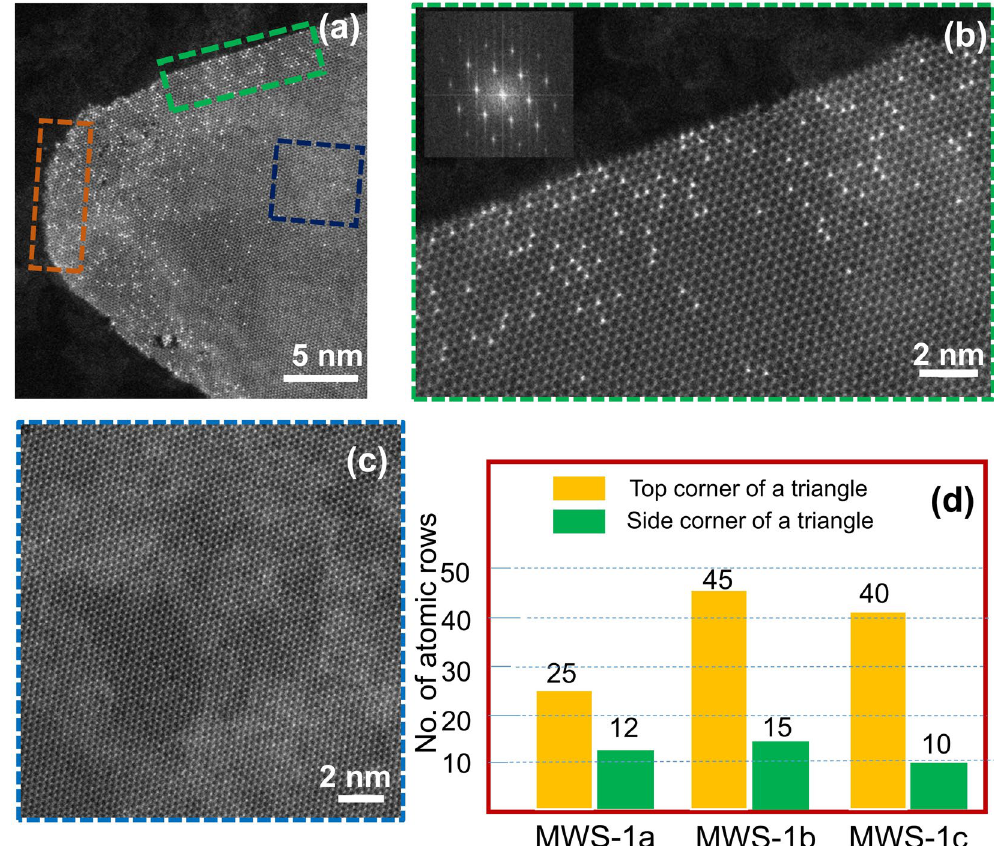
Figure 3. ( a ) An atomic-scale resolution ADF-STEM images of MWS-1b is displayed and an approximate area within green rectangular and blue square regions marked are illustrated in ( b ) and ( c ), respectively. Orange rectangle also depicts the region of top-edge doping, and the green rectangle depicts the region of side-edge doping. Inset in ( b ) display a FFT of the shown region which portrays a single crystalline nature of a monolayer, all three shows the distribution of W doping within a monolayer, effective doping around the corners of a flake, while the interior part ( c ) portrays with no dopants. ( d ) Histogram of the amount of the top and side corner